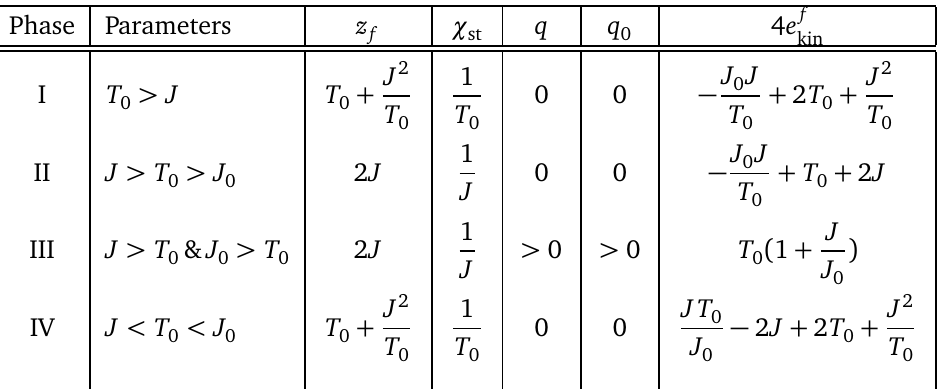
Table 1: Control parameters and relevant measurements : the asymptotic La- grange multiplier z , the static susceptibility χ , the limit of the self-correlation f st ) , the asymptotic correlation with the initial condition q = lim C ( t , t lim t →∞ t w →∞ w = lim = 〈 e 〉 q C ( t ,0 ) , and the kinetic energy density e f , in the four phases t →∞ 0 kin i . c . kin = 2 e f − z / of the phase diagram. We recall that e f f kin